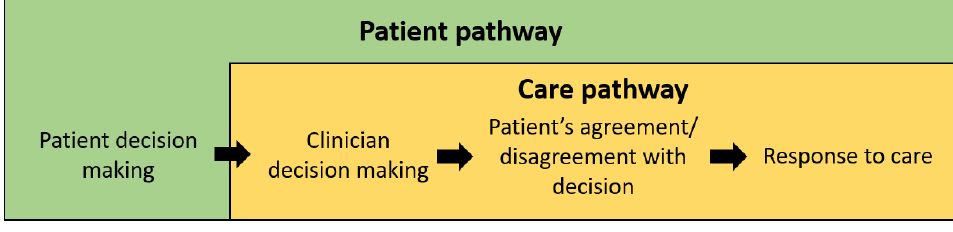
Figure 2. The patient and care pathway.